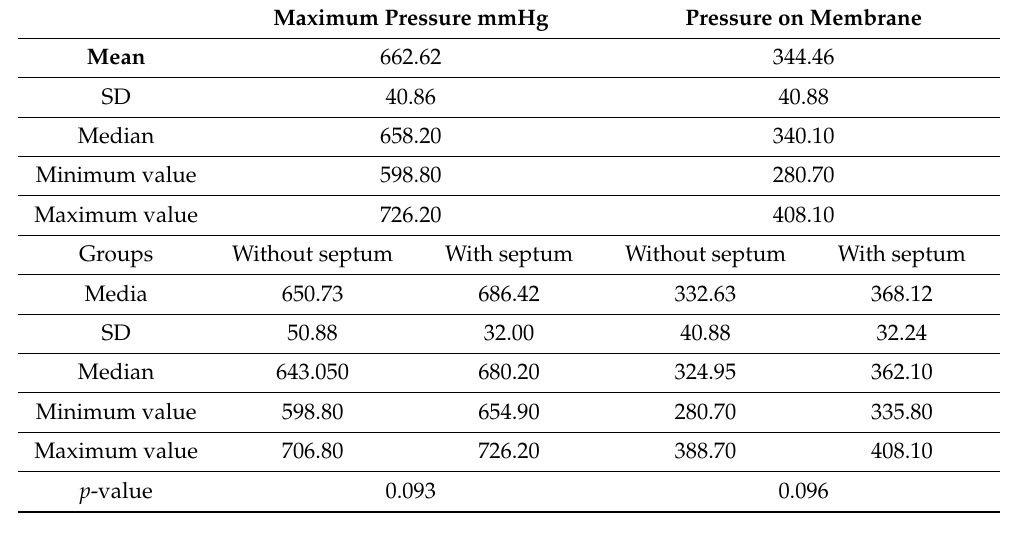
Table 5. Distribution and comparison of maximum pressures and pressures on the membrane in the global sample and in the sinuses with and without a septum.